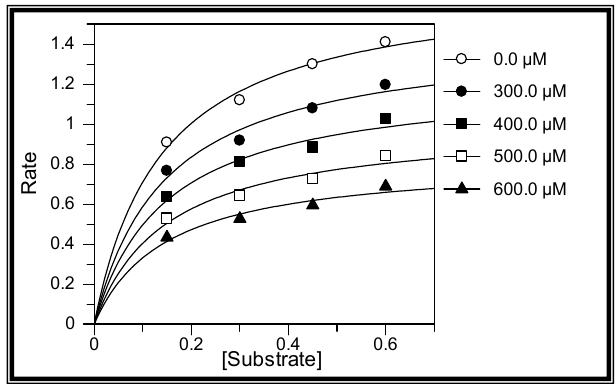
Figure 1. Rate of the reaction vs substrate at different concentrations of 1.